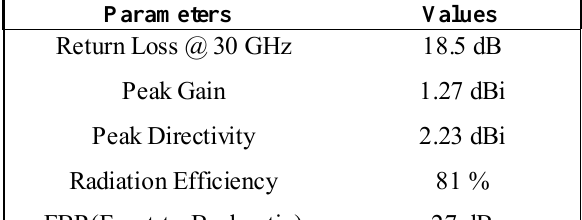
Table-X: Overall performance of the phased-array antenna